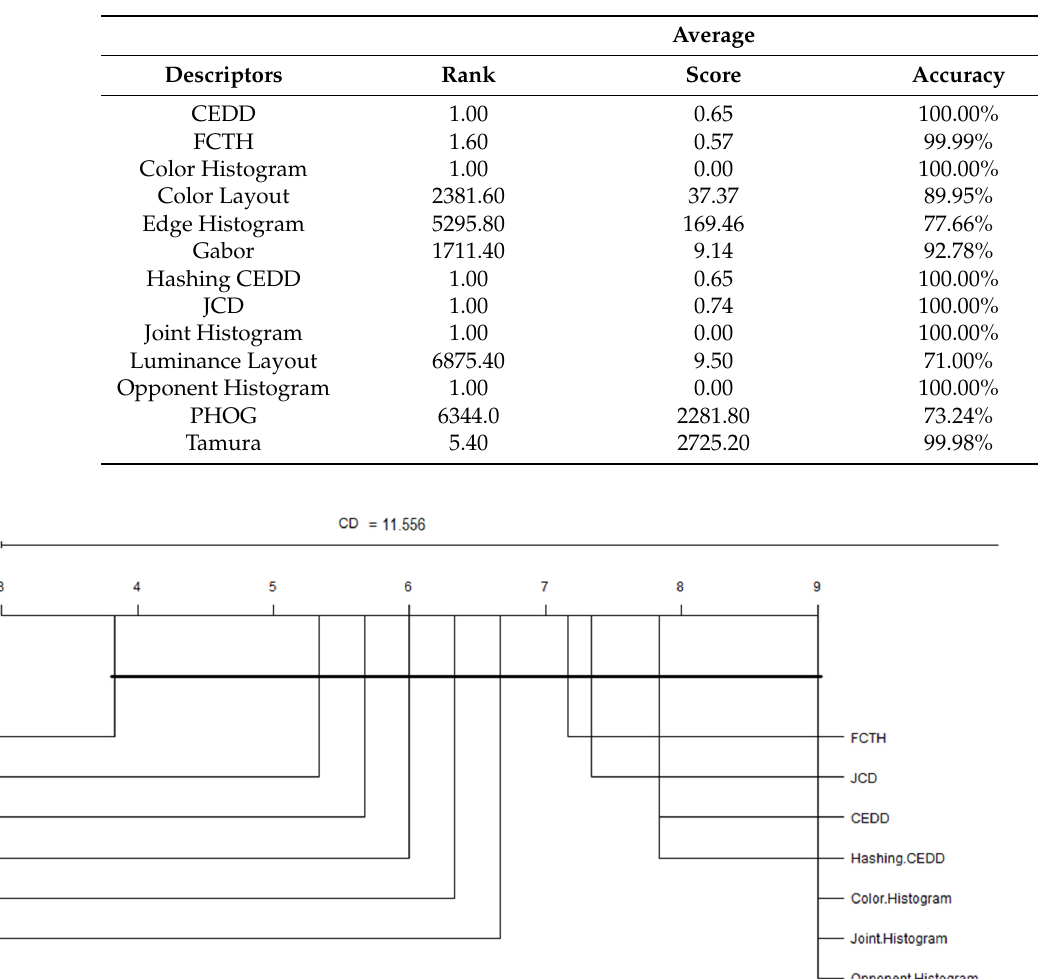
Table 3. Descriptors’ performance for retrieving rotated face images.